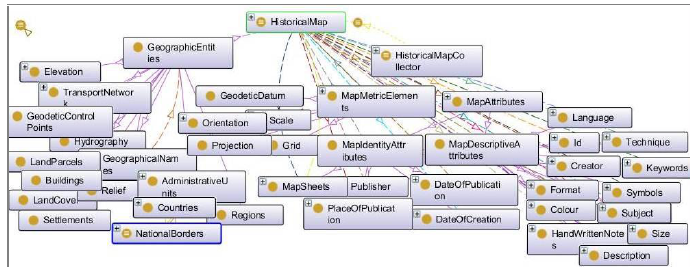
Figure 4. Excerpt of the ontology for the class HistoricalMap